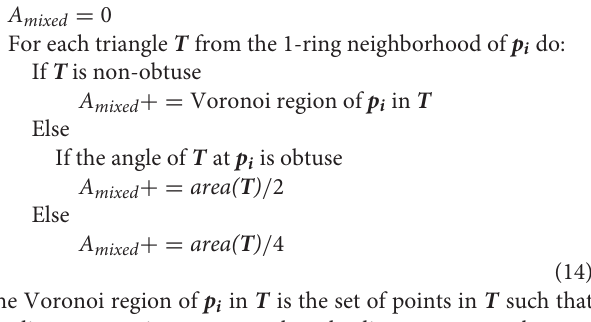
obtuse triangle the area connected with the midpoint of the edge opposite to the obtuse angle. A mixed can be calculated with